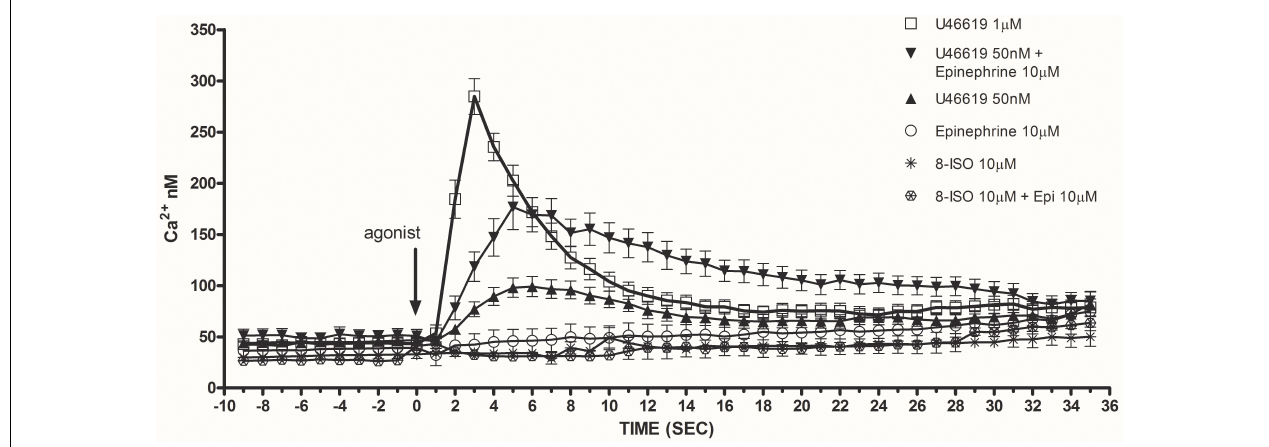
FIGURE 2 | Maximal release of intracellular calcium in washed and non-aggregating platelets (in presence of ASA 100 µ M, apyrase VII 10 U mL − 1 , eptifibatide 10 µ g mL − 1 ) stimulated by U46619 1 µ M, U46619 50 nM, U46619 50 nM + epinephrine (epi) 10 µ M, epi alone 10 µ M, 8-iso PGF2 α 10 µ M, 8-iso PGF2 α 10 µ M + epi 10 µ M (Ca 2 + nM). Repeated-measures Two-Way ANOVA was applied to compare the effects of platelets agonists at different time points. Significant differences ( P < 0.0001) were observed comparing U46619 1 mmol/L with all the other agonists, except U46619 50 nM + epi 10 µ M. Data are expressed as Mean ±